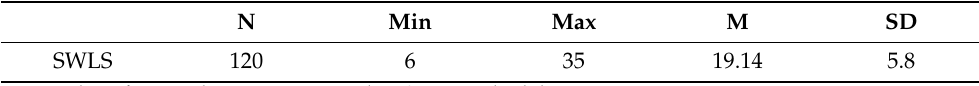
Table 4. General SWLS index.